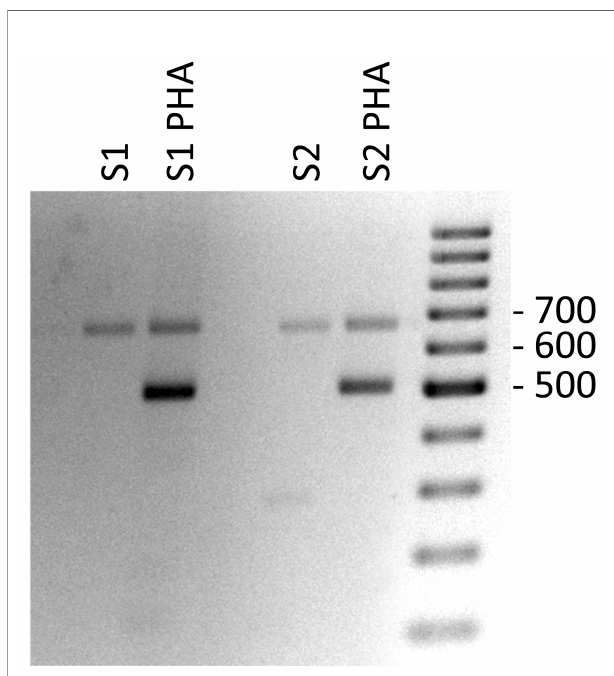
FIGURE 3 | Gel electrophoresis of PD-1 cDNA ampli fi cation products from PHA stimulated PBMCs of celiac patients as control positive of T cell